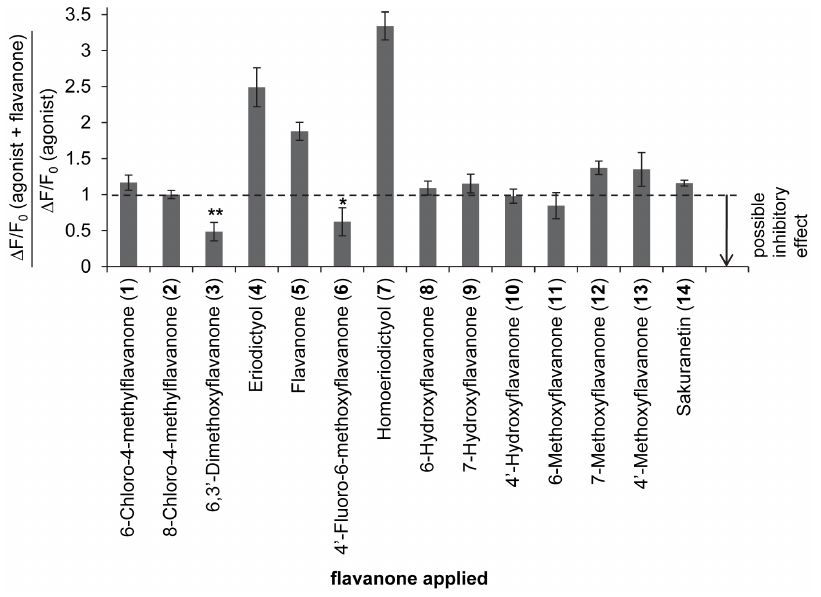
Figure 2. Screening of flavanones for reduction of ECG response on hTAS2R39. Screening was performed with simultaneous application of agonist (200 m M ECG) and putative antagonist (250 m M flavanone). Inhibition was indicated when